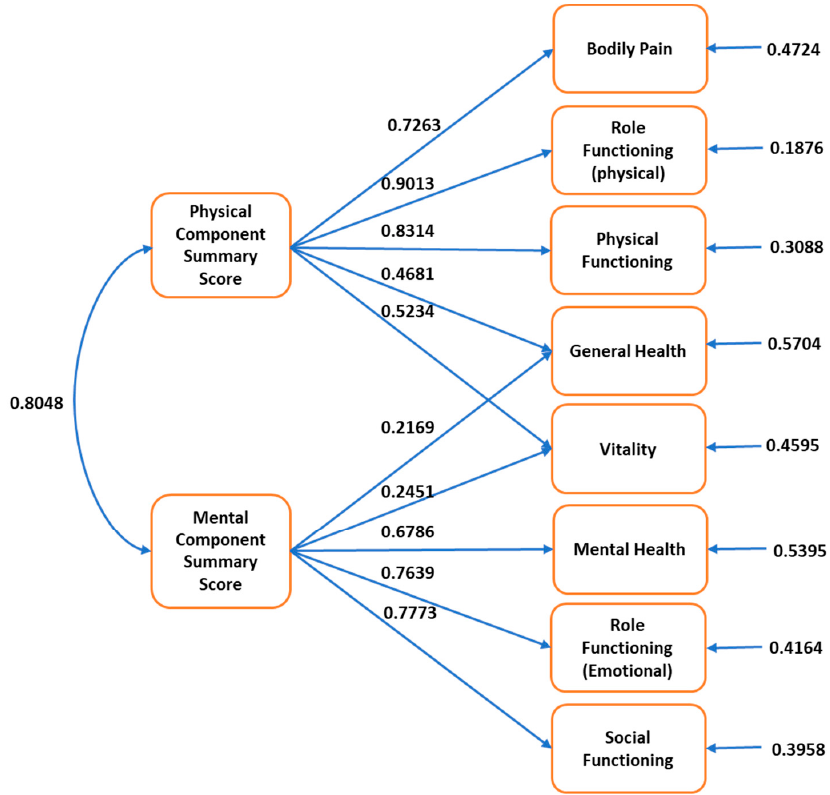
Figure 2. Results of confirmatory factor analysis for structural validity of Physical Component Summary Score and Mental Component Summary Score in the Short-Form 12-Item Survey—version 2 among an older (65 years or greater) US population. Table 3. Fit summary statistics of confirmatory factor analysis for structural validity of Physical Component Summary Score and Mental Component Summary Score in the Short-Form 12-Item Survey—version 2 among an older (65 years or greater) US population 1 .